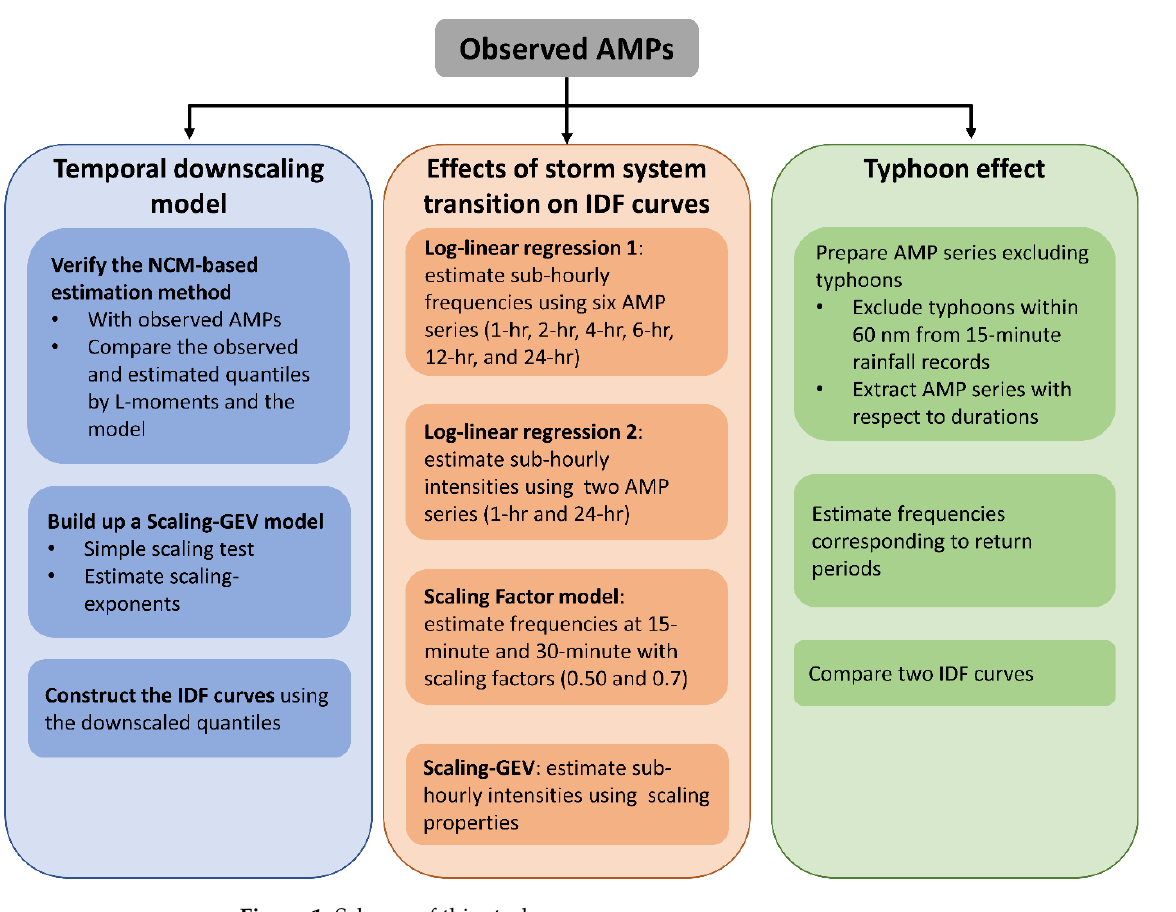
Figure 1. Scheme of this